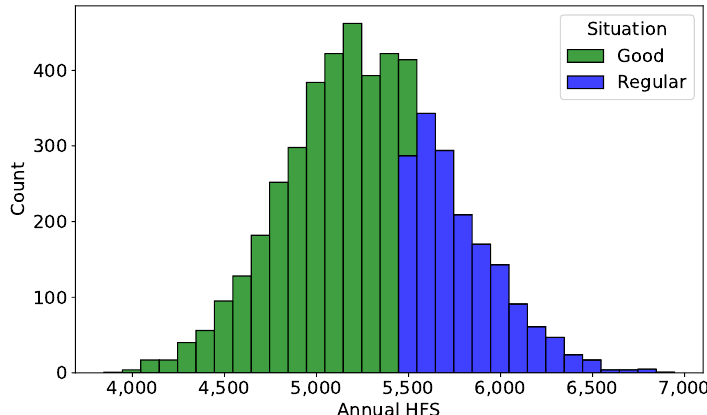
Figure 11. Histogram Highlighting Possible Operating Situations—Simulation II.